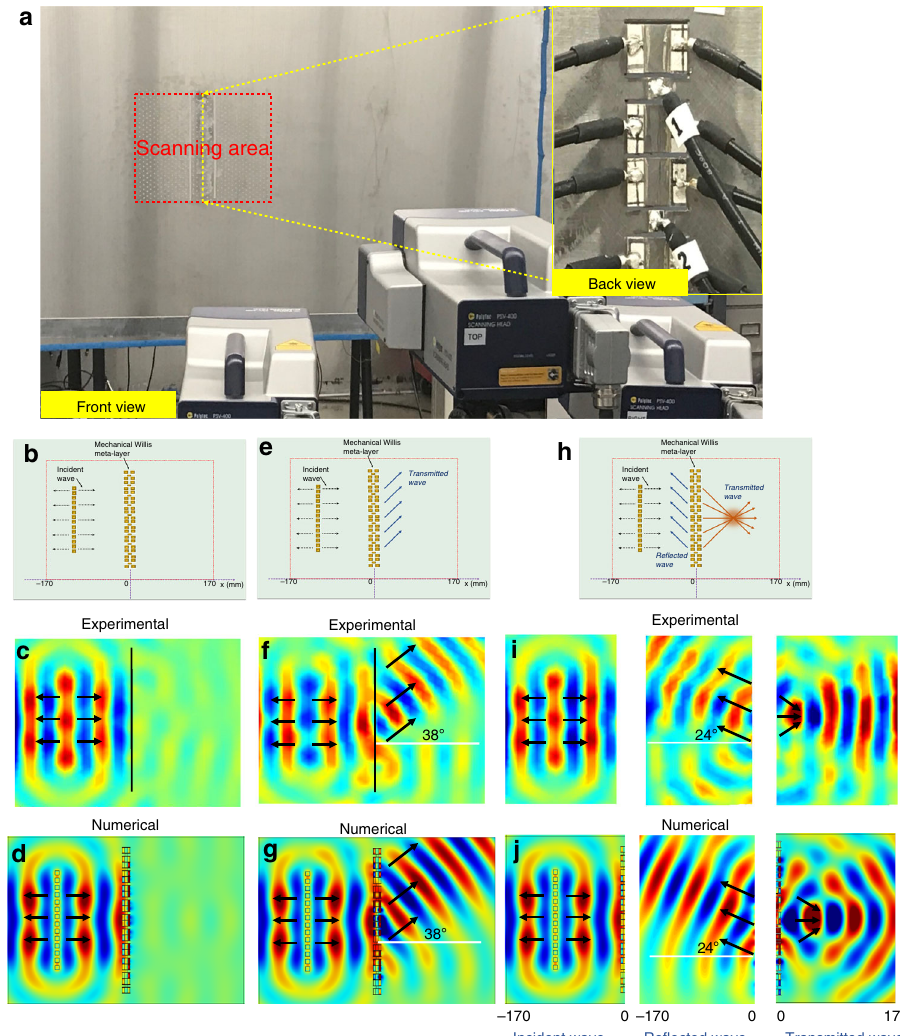
Fig. 5 Experimental demonstrations of the Willis meta-layer in plates. a Image of the experimental setup of the fl exural wave propagation through a Willis meta-layer in a plate with the Willis meta-layer, and re fl ected and transmitted regions highlighted. b – j Experimental and numerical demonstrations of the Willis meta-layer for ( b - d ) total wave absorption, ( e - g ) wave steering in the transmitted domain and ( h - j ) simultaneous wave focusing and steering in both transmitted and re fl ected domains, respectively. Source data are provided as a Source Data fi